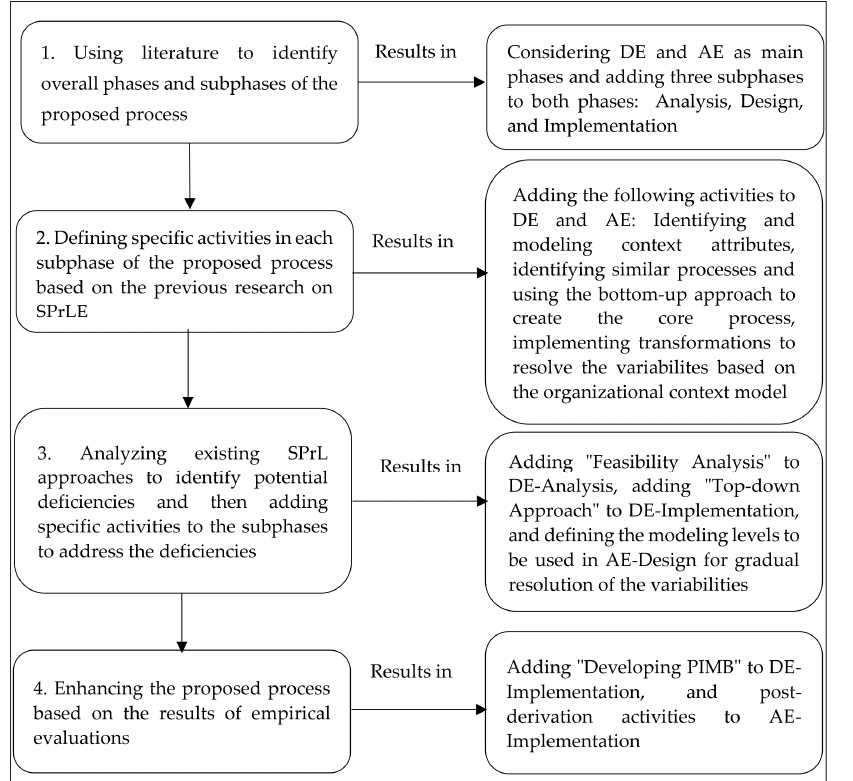
Figure 1. The research methodology used to build the SPrLE process.